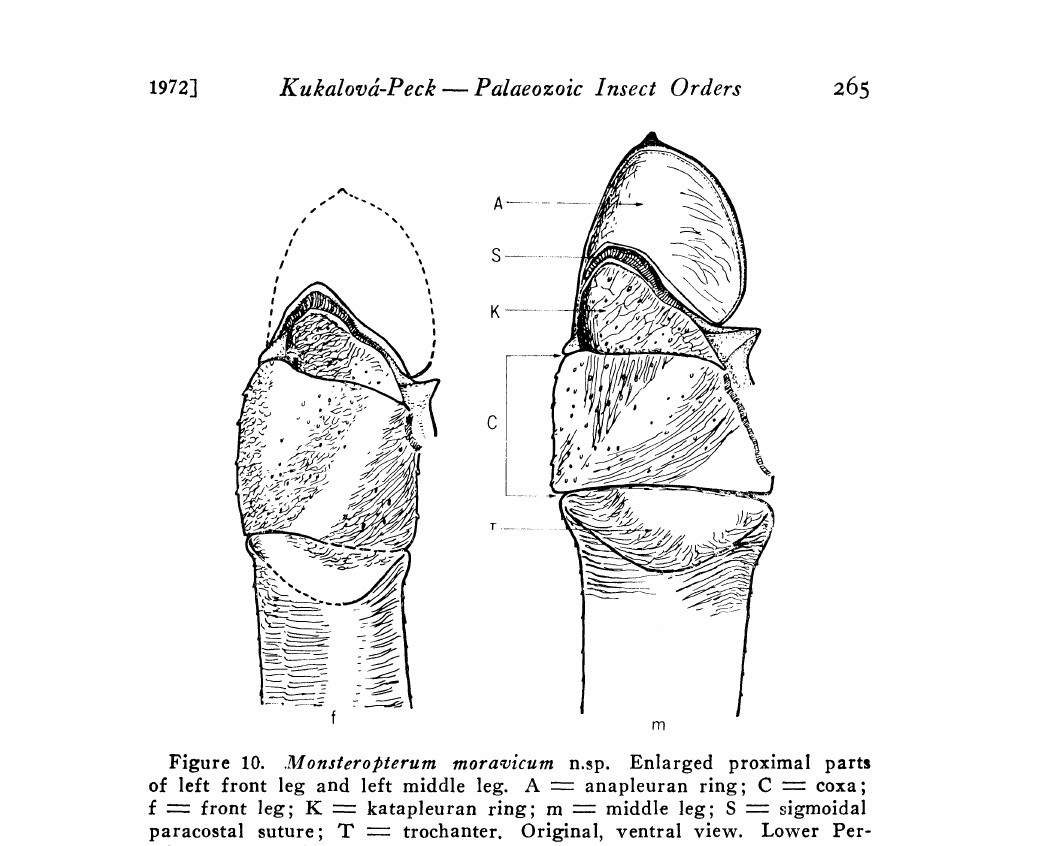
Figure 10. .Monsterolterum moraicum n.sp. Enlarged proximal parts of left front leg and left middle leg. A anapleuran ring; C coxa; f front leg; K katapleuran ring; m middle leg; S sigmoidal paracostal suture; T trochanter. Original, ventral view. Lower Per- mian of